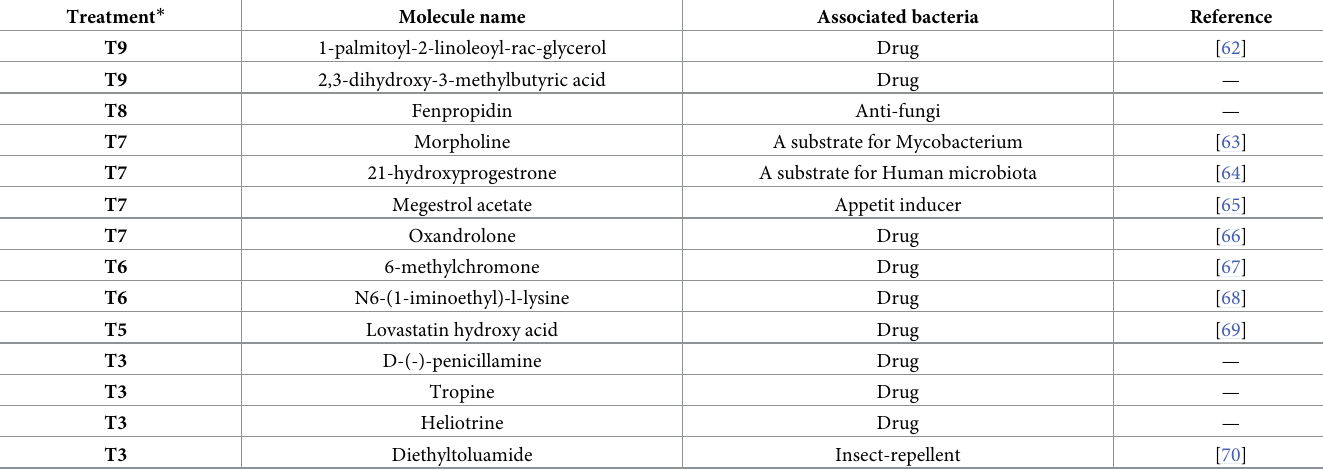
Table 3. Biofloc xenobiotics derived